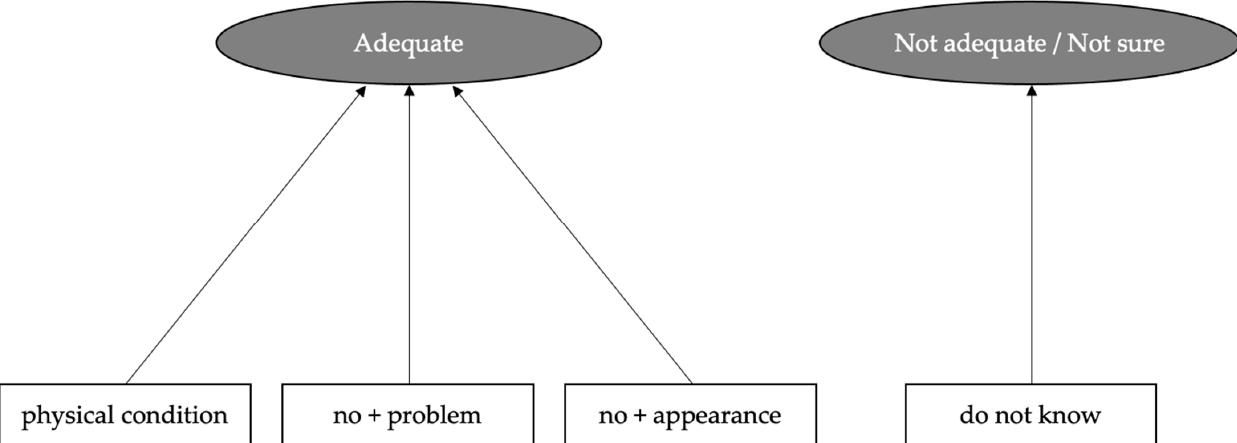
Figure 2. Analysis of word relationships visualizing the characteristic words that appear frequently in an open-ended response by para-athletes with reference to the subjective assessment of the amount of daily food intake (i.e., ‘Adequate’ or ‘Not adequate’/‘Not sure’). Colored circles indicate the answers to the subjective assessment of the amount of daily food intake and white squares indicate words that appear frequently in an open-ended response. The frequent words in an open-ended response by para-athletes who answered ‘Adequate’ were ‘physical condition’, ‘no + problem’ and ‘no + appearance’.